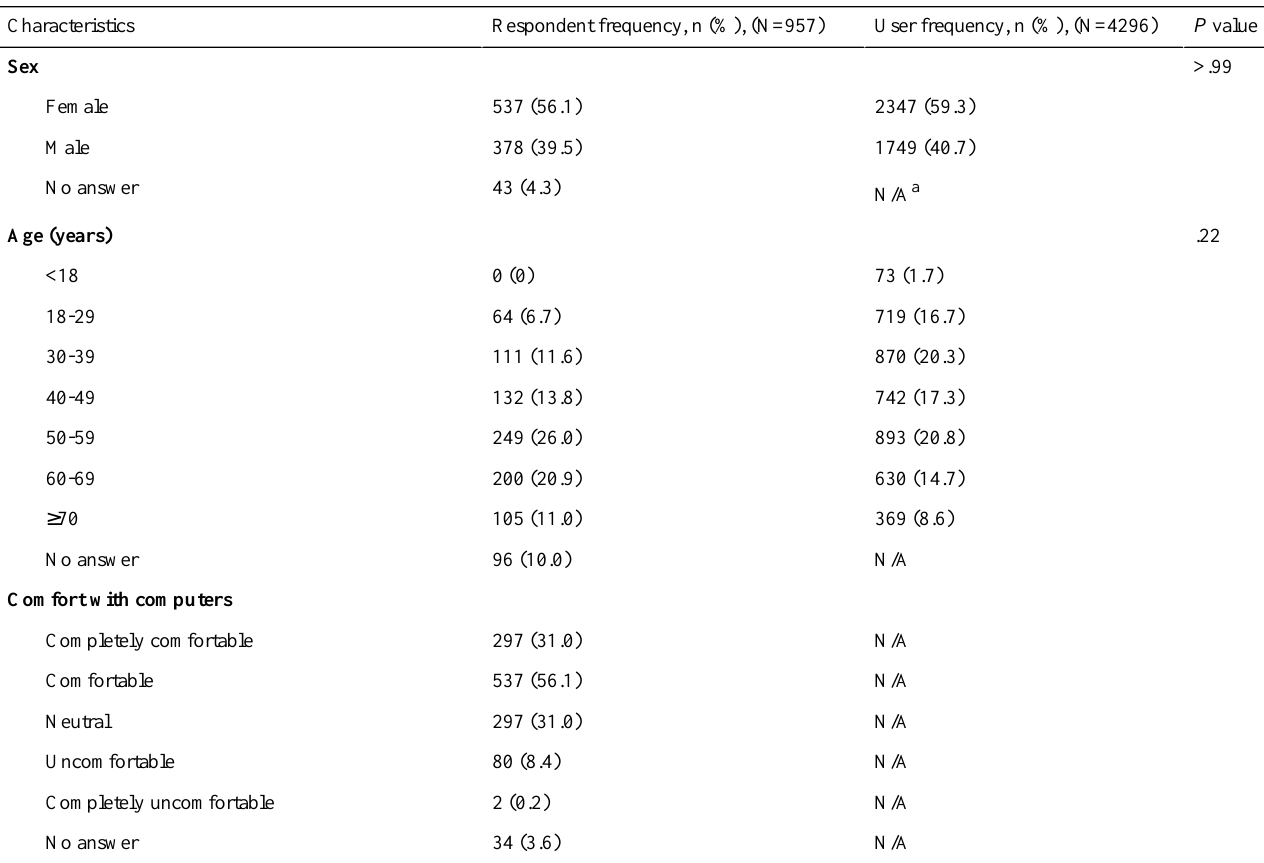
Table 1. Patient portal user and respondent